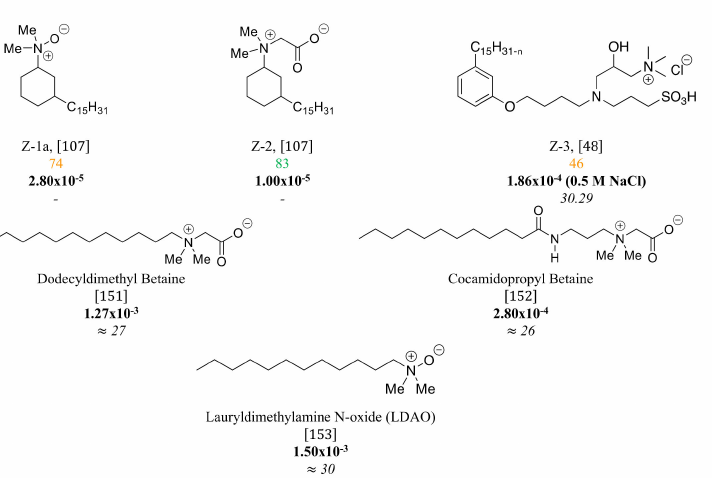
Figure 12. % bio (green for % up to 75%, and orange in between (50–75%), CMC (mol/L, bold) and surface tension (mN/m, italics) of zwitterionic CNSL-based